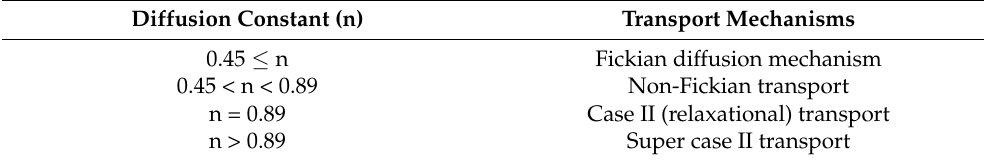
Table 3. Diffusion mechanisms of the drug according to the diffusion constant (n) value.